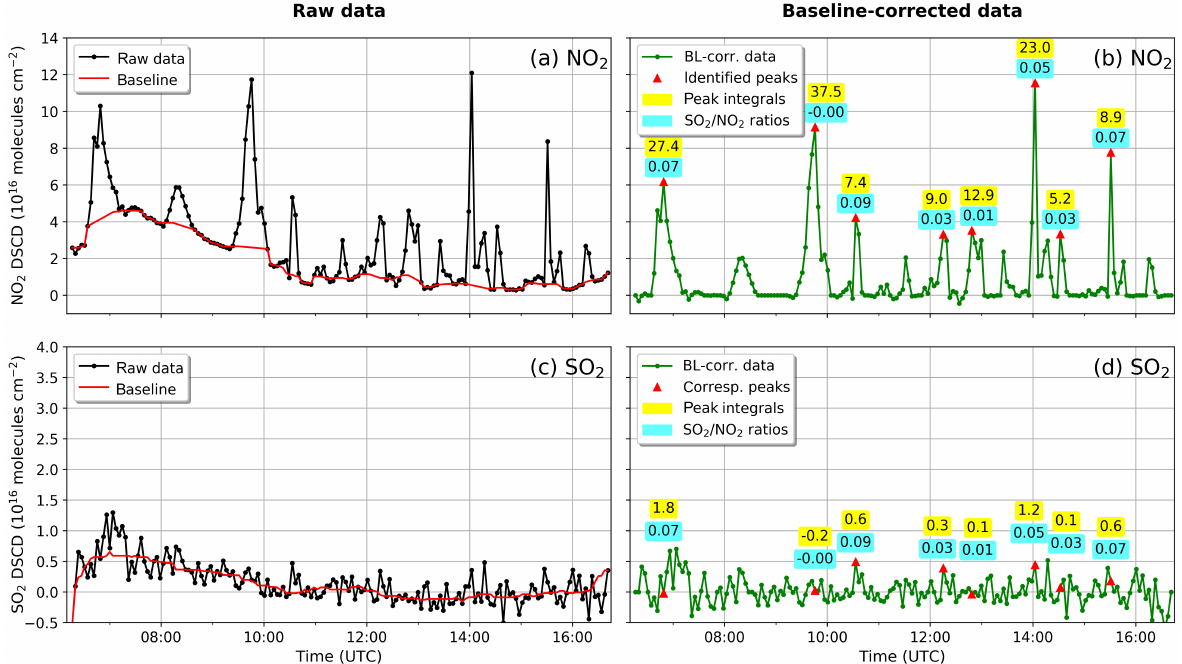
Figure 19. As Fig. 18 but for an example day (3 July 2015) after the introduction of stricter fuel sulfur content limits. Measurements at 0.5 ◦ elevation and 65 ◦ azimuth are shown. Peak integrals are given in 10 16 moleculescm − 2